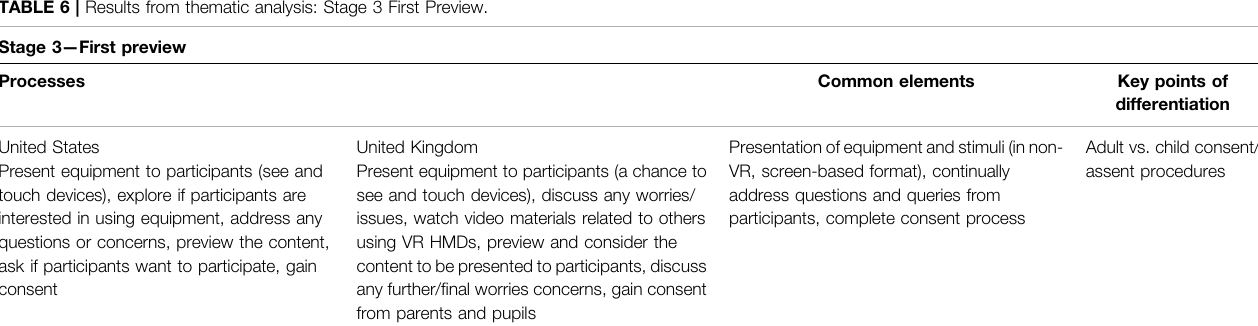
TABLE 6 | Results from thematic analysis: Stage 3 First Preview.